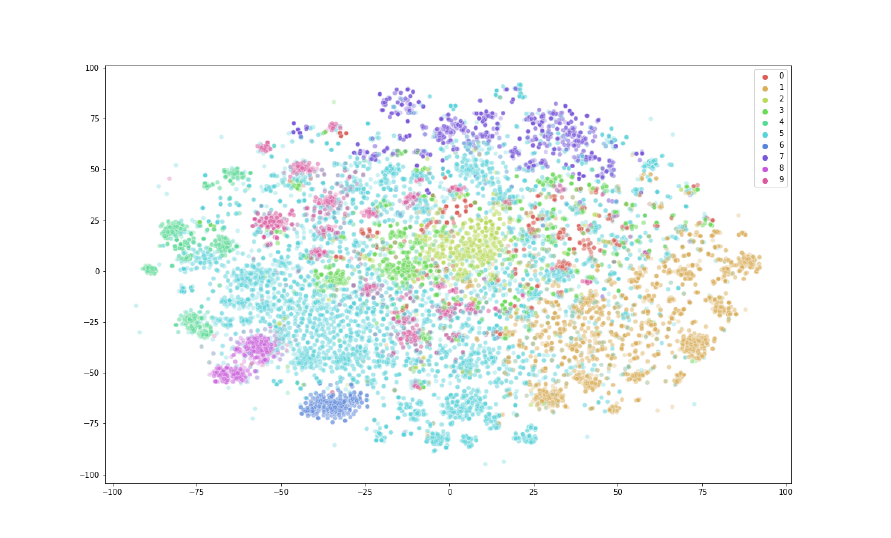
Figure 5. Visualization of 10 K-means clusters for RCV1 using t-SNE.